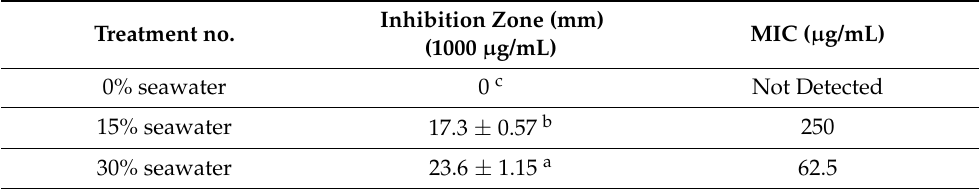
Different letters indicate salinity at different